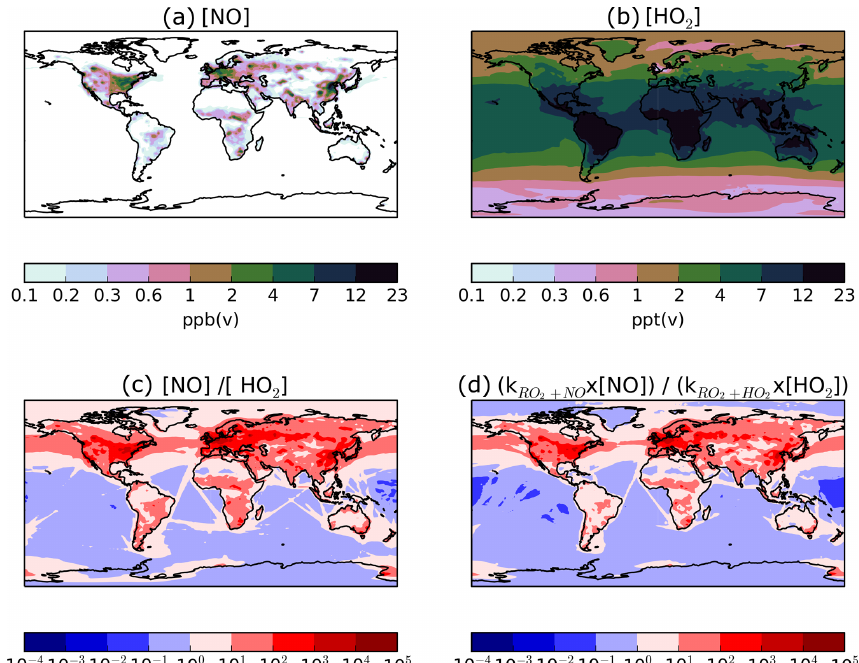
Figure 11. Global distributions of annual-average (a) surface NO concentrations (ppb(v)), (b) surface HO 2 concentrations (ppt(v)), (c) the ratio of surface NO / HO 2 , and (d) the ratio of surface (k RO 298K. Note that the concentrations of the HO 2 radical are in units of parts per trillion by volume, whereas NO is in units of parts per billion by